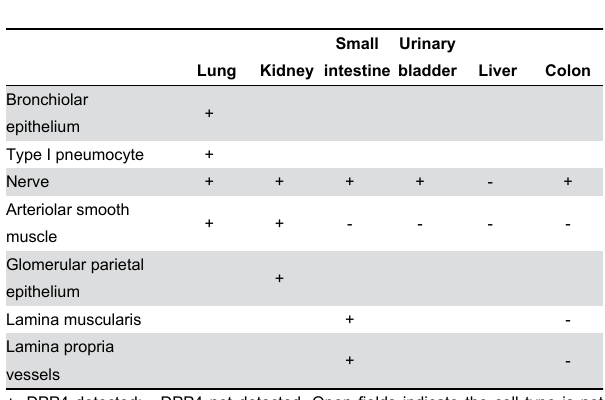
present in this tissue.